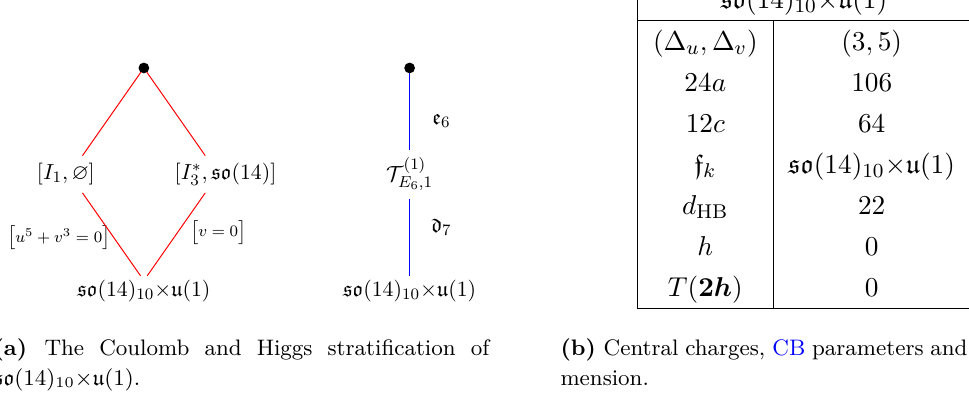
Figure 5. Information about the so (14) 10 × u (1)